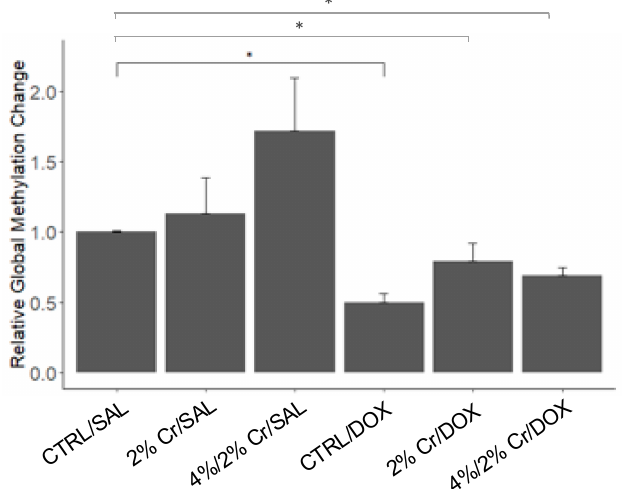
Figure 6. Quantification of 5-methylcytosine (%5-mC) to determine the change in global methylation and thus chromosomal stability using 5-mC ELISA. Higher levels of global methylation were found in groups that did not receive DOX whereas lower levels of global methylation were detected in groups that received DOX treatment. Additionally, when DOX was combined with Cr supplementation, levels of global methylation tended to increase. Data are reported as mean ± SE. * p < 0.05.